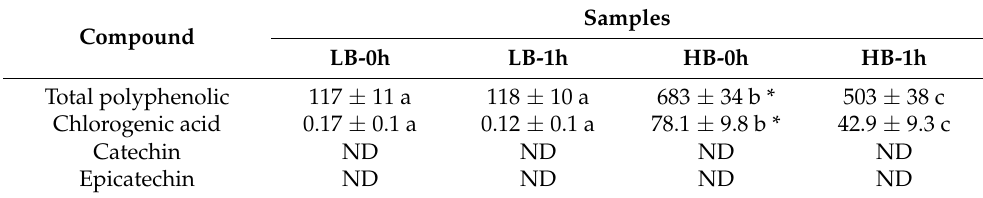
Table 1. Total and monomeric polyphenol ( µ g/g fresh weight) in two cultivars at 0 h and 1 h.